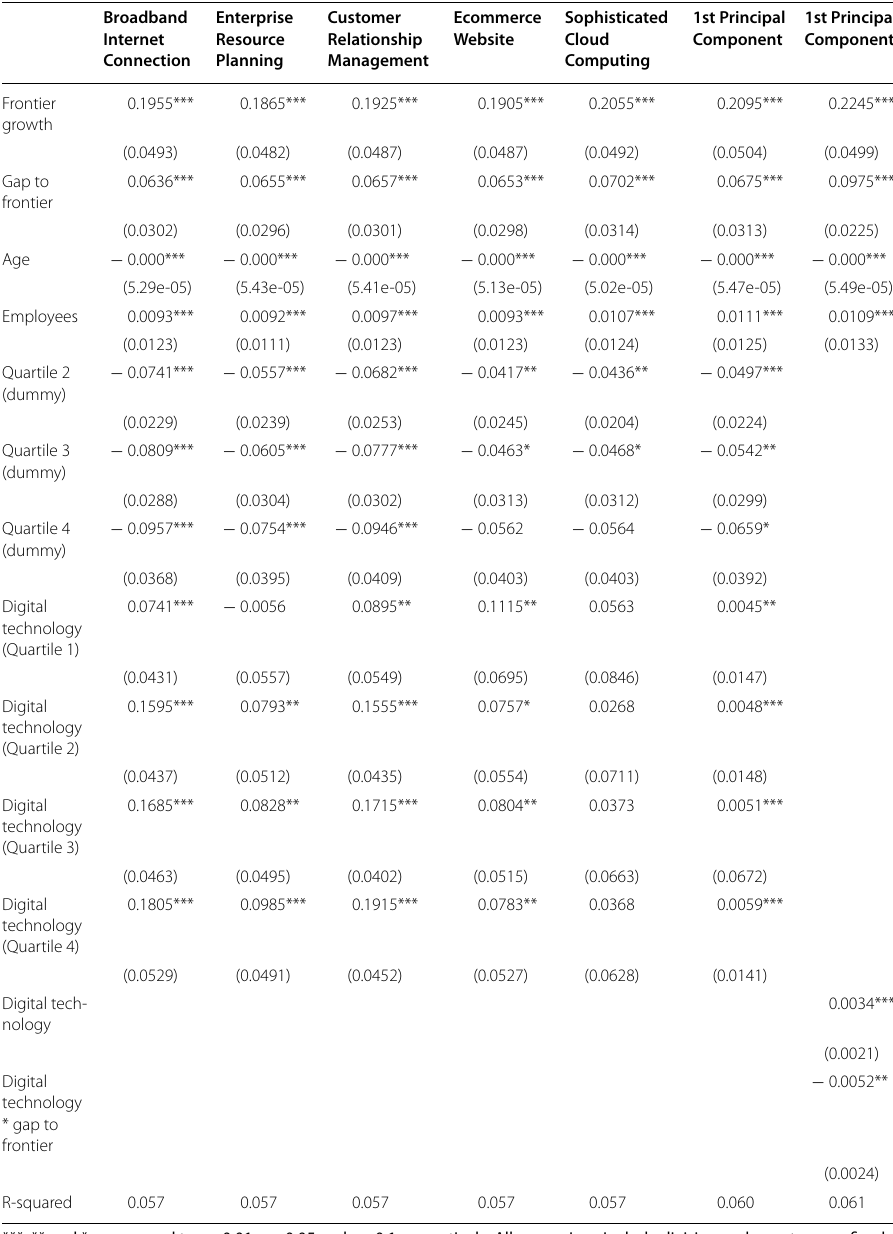
Table 8 The heterogeneous impact of digital adoption on efficiency